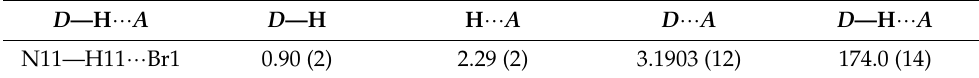
Table 5. Strong hydrogen-bond geometry (Å, º) for 4 .